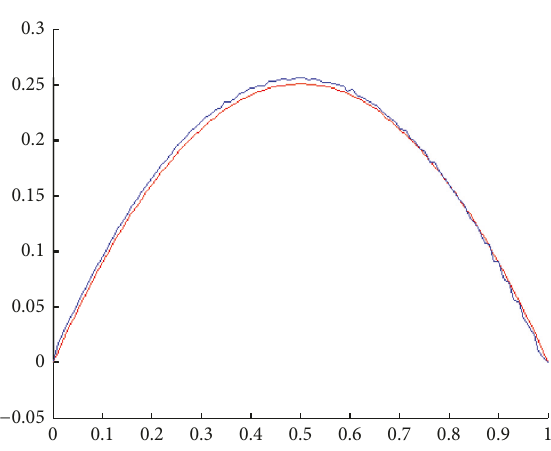
Figure16:Initialtemperatureinerr=20% ‖𝜓 exact 0 ‖ 2 case.Thisfigure shows that we cannot rebuild the true